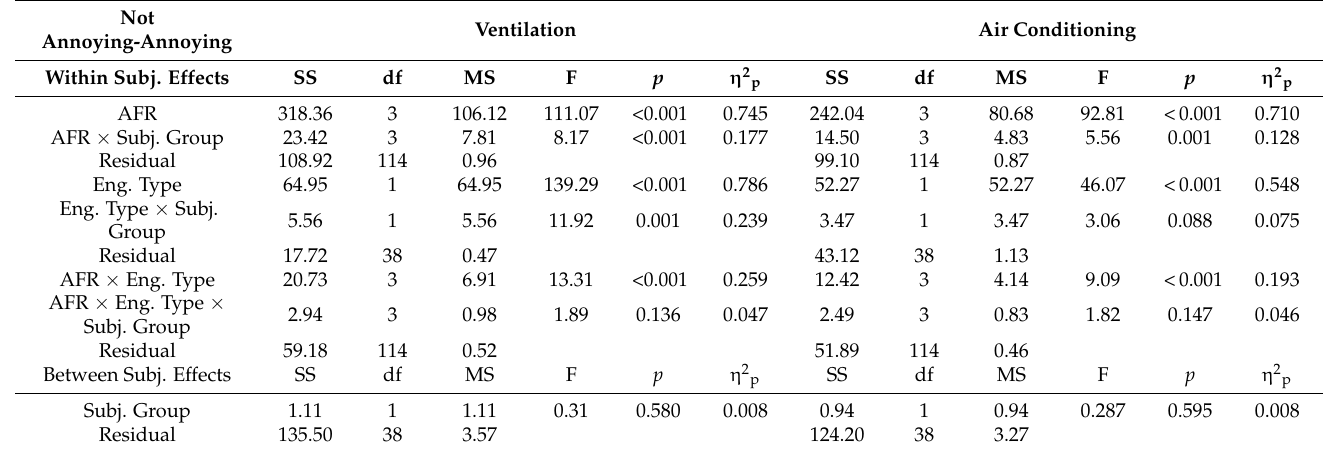
Table 3. ANOVA results for Not Annoying-Annoying .